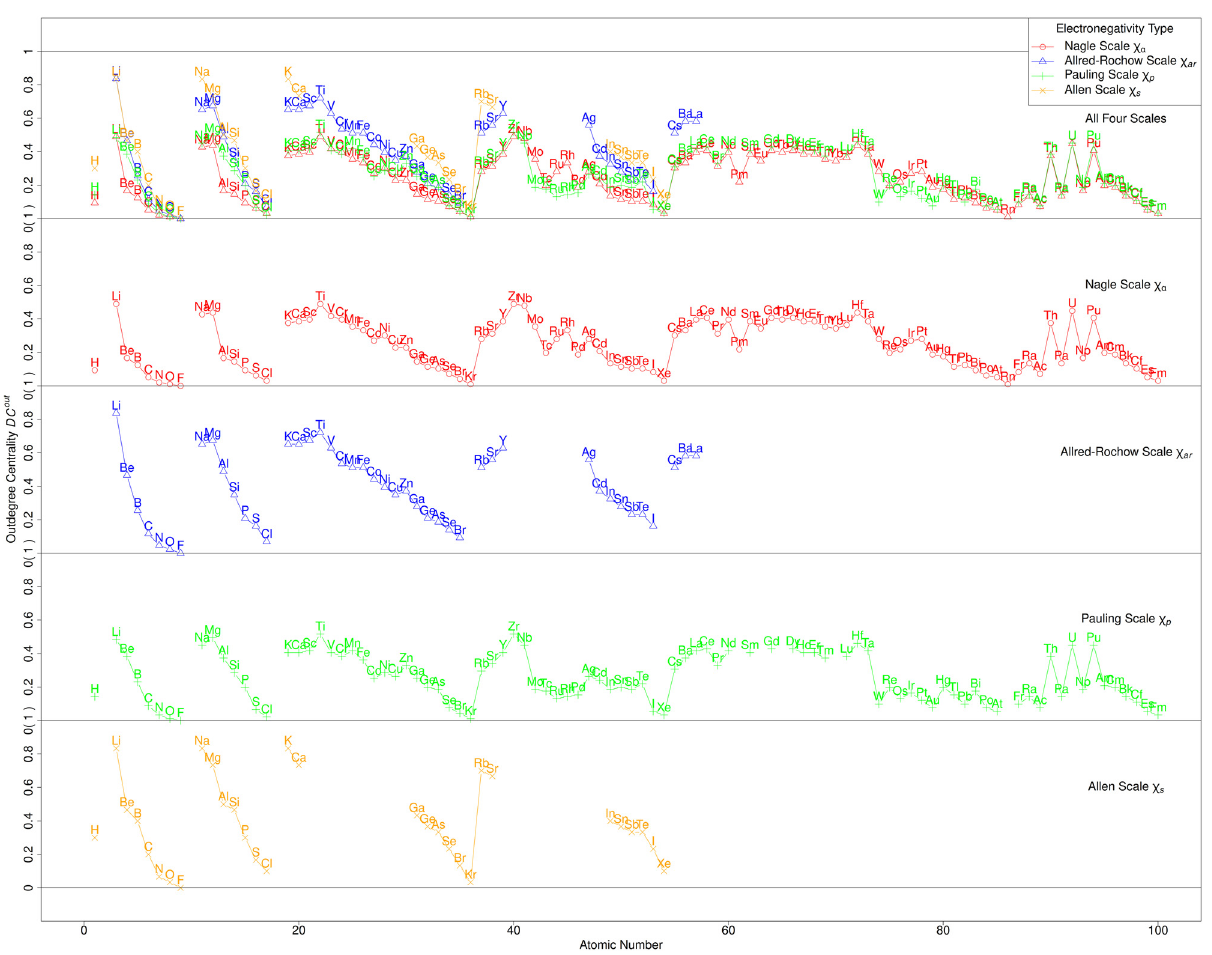
Figure 7: DC out changing trends in the four